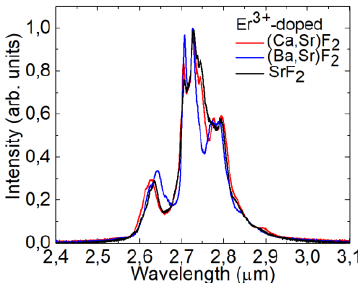
Fig. 4. Mid-infrared luminescence spectra for the 4 I 11/2 → 4 I 13/2 transition, λ exc = 970